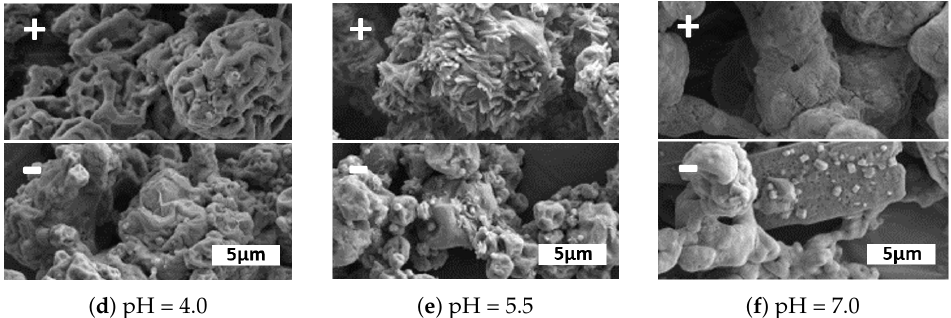
Figure 3. Morphology of spray-dried protein microparticles at variable pH/ionic strength in the ab- sence (parent micrograph) and presence (inset micrograph) of excipient. Excipients are aminopropyl functionalized silica in all cases. Scale bar is 5 µm for all micrographs. Formulations ( a – c ) contain 0% ( w/v ) CaCl 2 , whilst ( d – f ) contain 1.5% ( w/v ) CaCl 2 . pH is denoted below image.